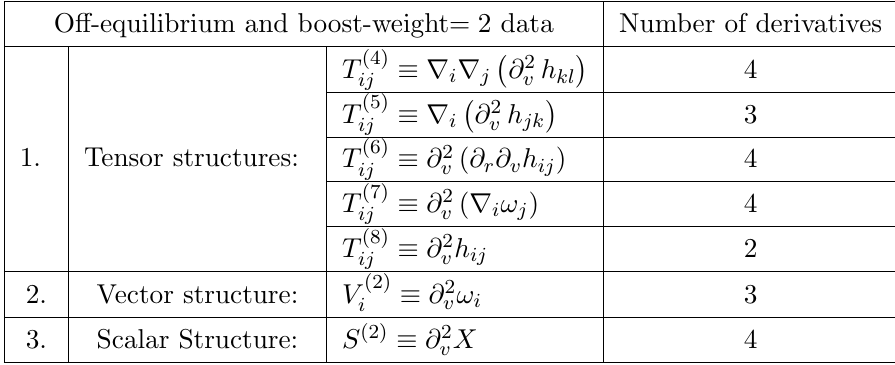
Table 6 . Relevant o(cid:11)-equilibrium data with maximum number of derivatives= 4 and boost-weight= 2, in four-derivative theories of gravity. Let us emphasize that within the tensor structures there are three types of terms: ( i ) 4-index structure: T (4) , ( ii ) 3-index structure: T (5) ij structure: T (6) ; T (7) and T (8) ij ij ij